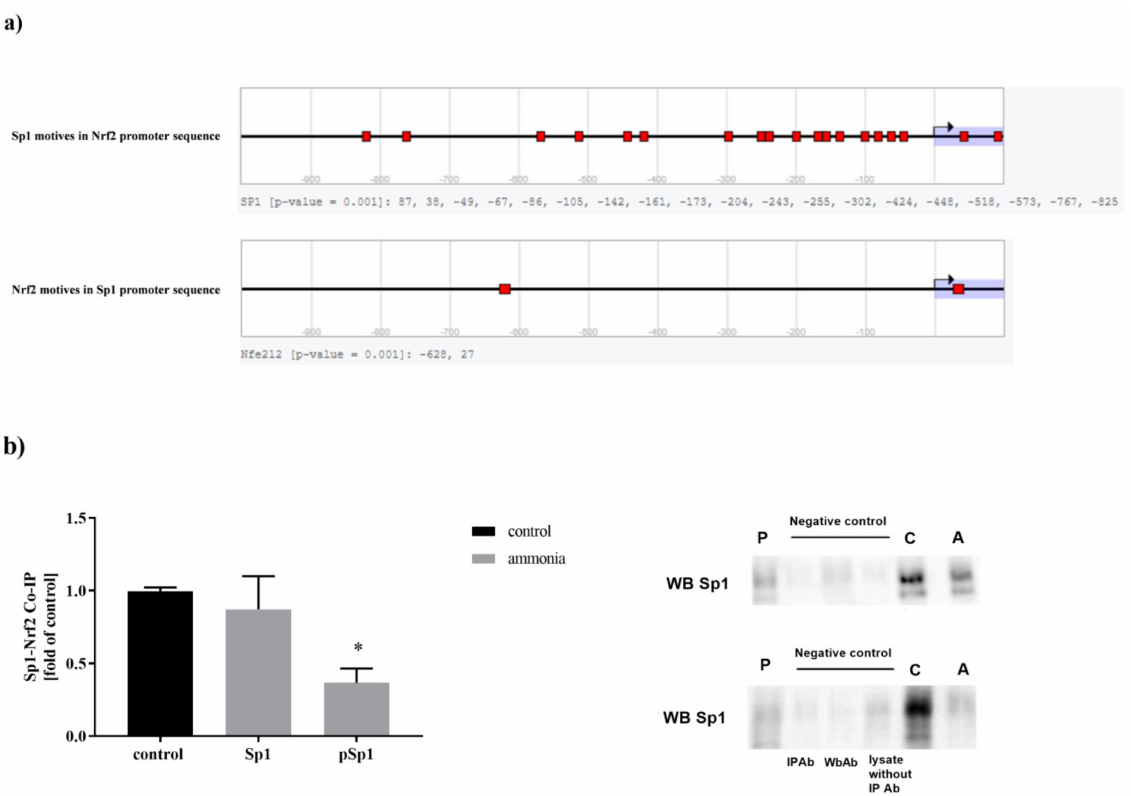
Figure 5. ( a ) In silico analysis of Sp1 and Nrf2 motives in Nrf2 and Sp1 promoter sequences respectively using the DBTSS database. ( b ) Co-immunoprecipitation of Sp1 and phosphorylated Sp1 (pSp1) with Nrf2 transcription factor in mouse cortical astrocytes in the absence or presence of 5 mM ammonia. The left panel shows summary data for mean densitometry of co-immunoprecipitation immunoblots, right panel, the representative co-immunoprecipitation immunoblot. Results are the mean ± SD ( n = 4). (*) p < 0.05 vs. control; one-way ANOVA, Dunnett’s post hoc